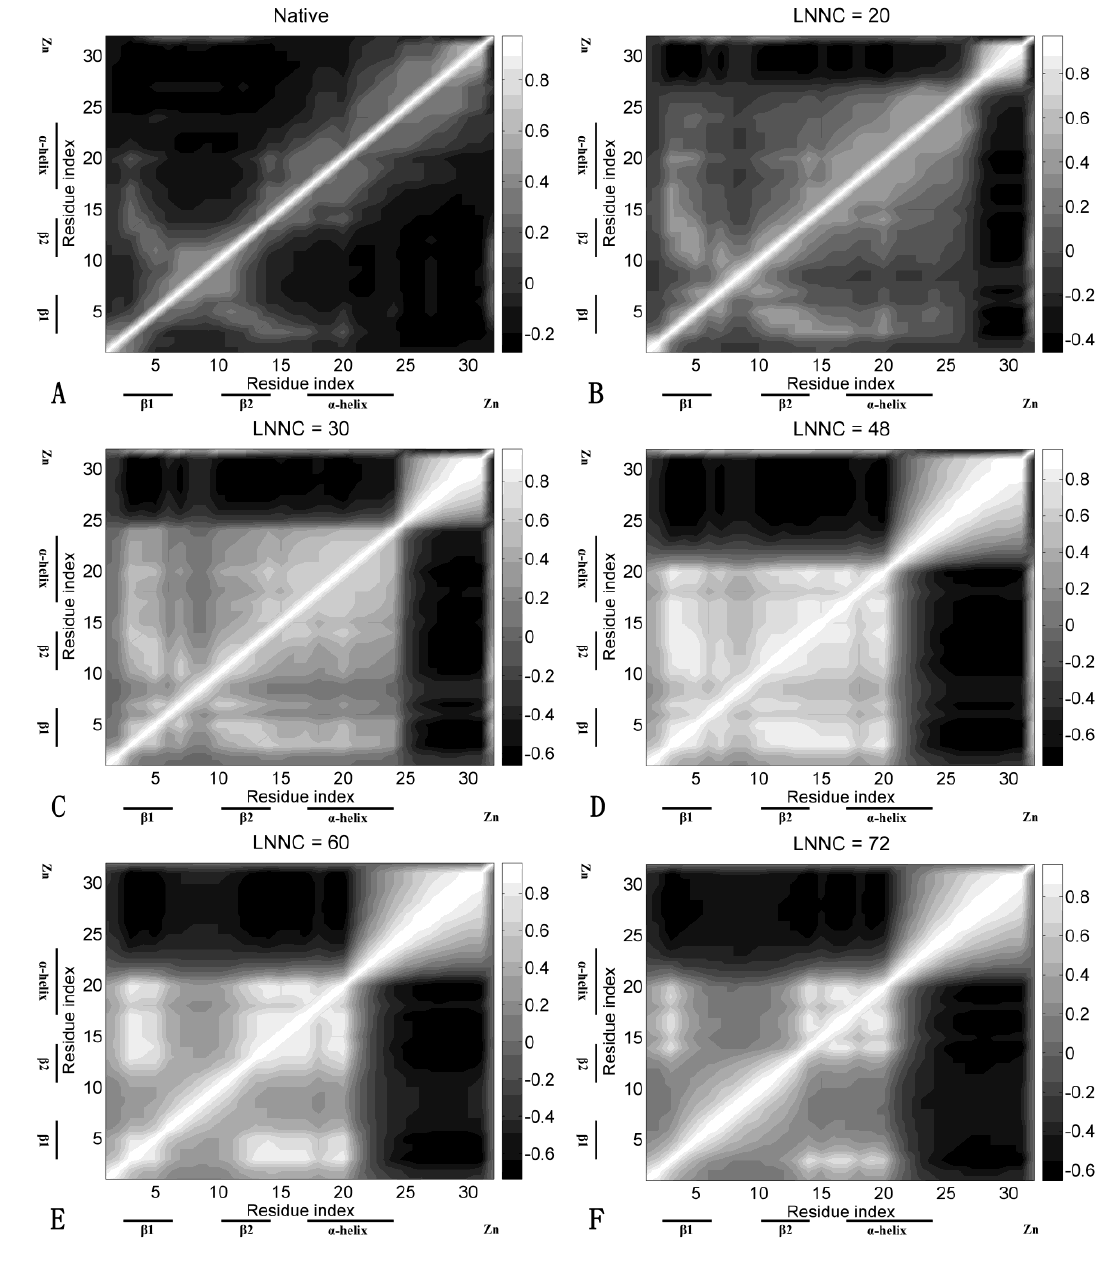
Figure 8. The cross-correlation maps calculated using all modes for native conformation ( A ) and several conformations with LNNC to be 20 ( B ), 30 ( C ), 48 ( D ), 60 ( E ) and 72 ( F ) during the unfolding process of Sp1f2. As shown in the bar on the right, the dark regions in the figure indicate negative correlation and the light regions present positive correlation. Both the x and y axes of the maps are residue